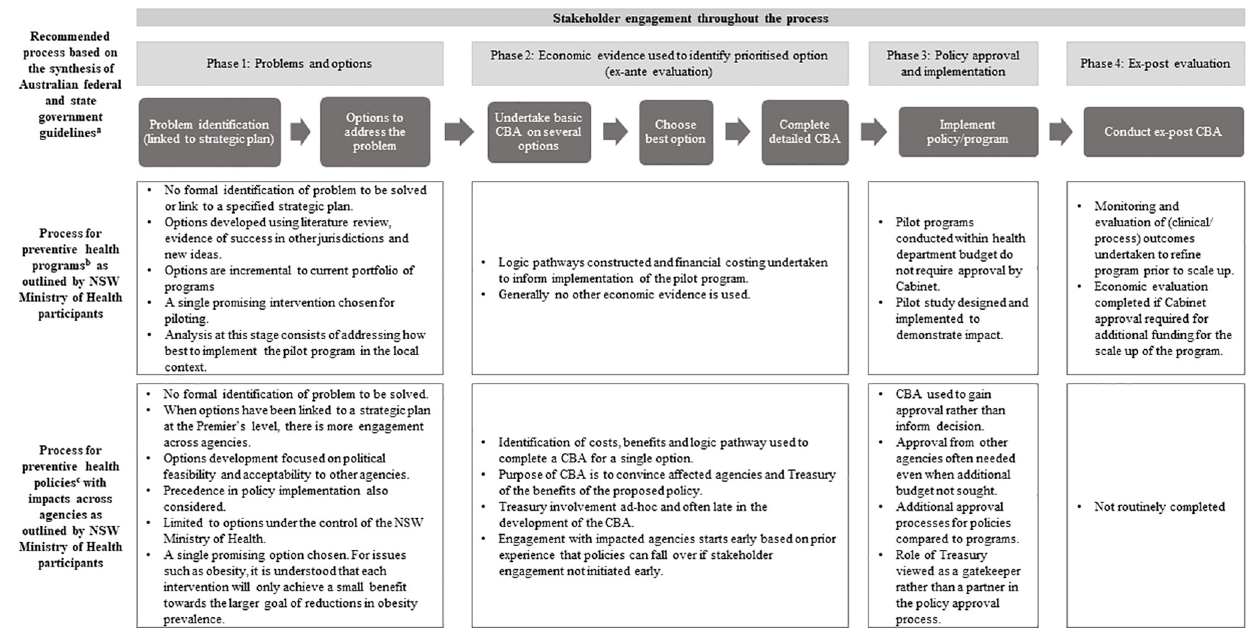
Fig 1. NSW Ministry of Health resource allocation process for preventive health mapped to the process recommended by official federal and state guidelines.